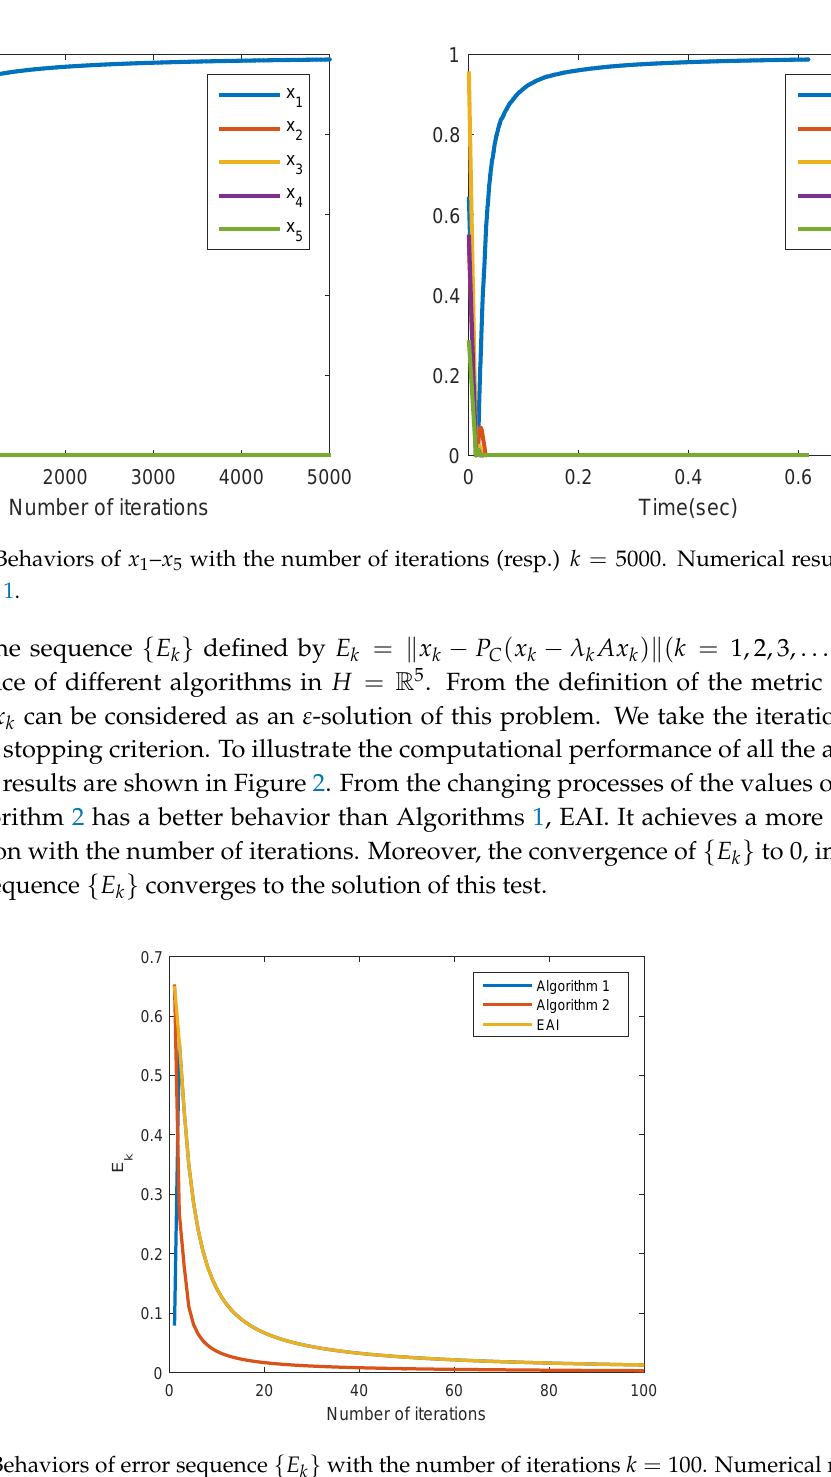
Figure 2. Behaviors of error sequence { E k } with the number of iterations k = 100. Numerical results for Algorithms 1 and 2 and